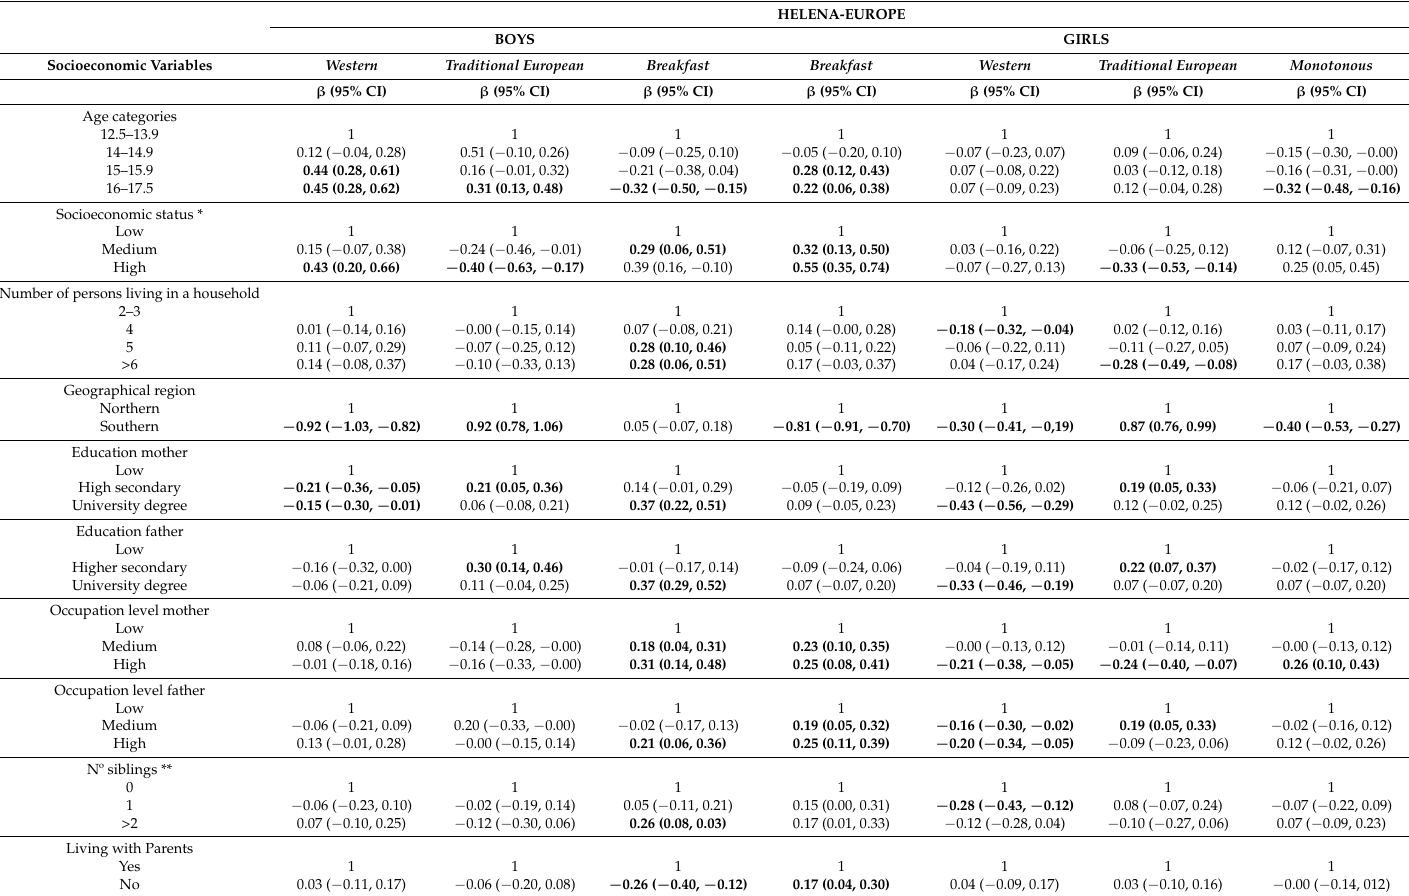
Table 4. Gender-specific regression β -coefficients (95% IC) between indicators of socioeconomic status and mean scores of DP in adolescents participating in the HELENA-Europe 2006/2007